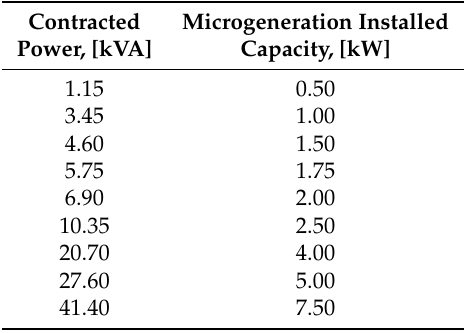
Table 2. Network characterization. Generation installed capacity, according to the contracted power.